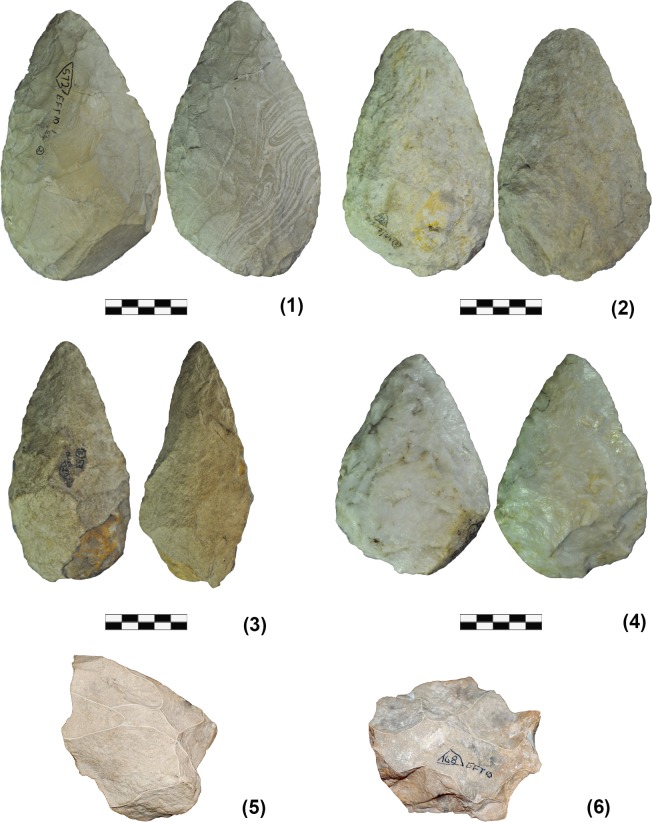
Archaeological specimens.The figure displays Mode 1 cores and Mode 2 LCTs from Elandsfontein Cutting 10 assemblage: (1) EFT_572 (Mode 2:silcrete), (2) EFT_921 (Mode 2:silcrete), (3) EFT_622 (Mode 2:silcrete), (4) EFT_579 (Mode 2:quartz), (5) EFT_182c (Mode1:siclrete), (6) EFT_168a (Mode 1:silcrete).